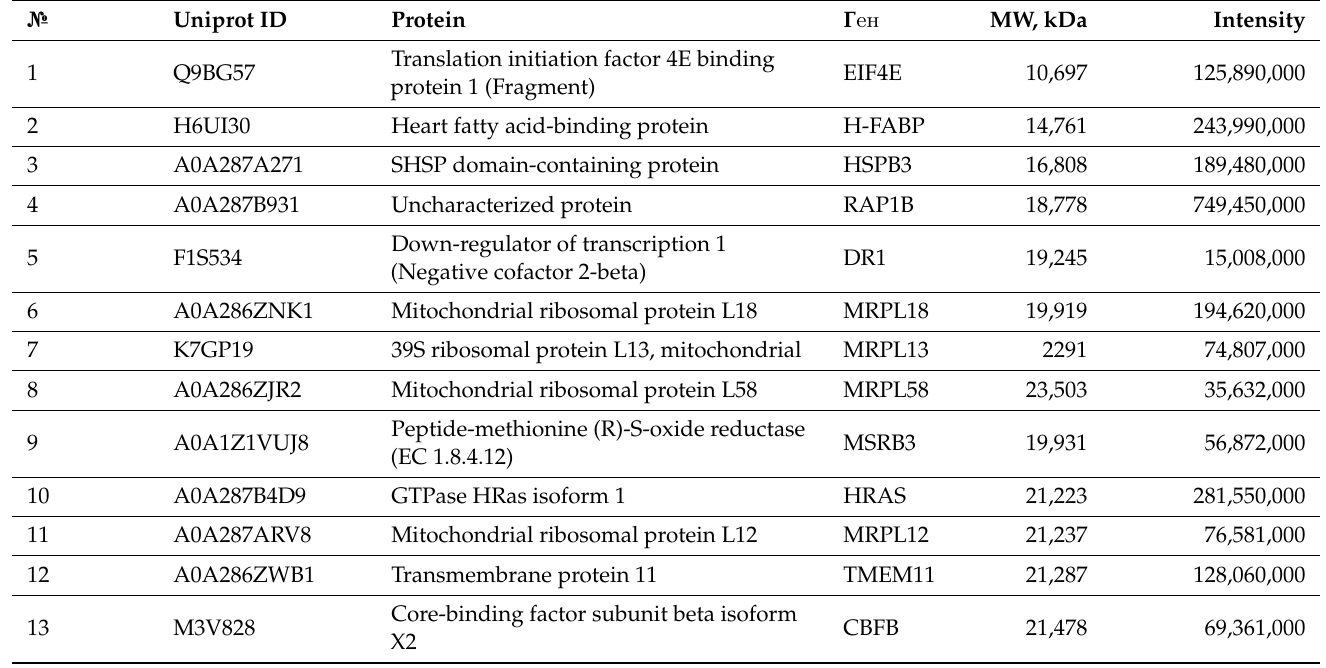
Table 1. Unique proteins identified in the muscle tissue of convalescent